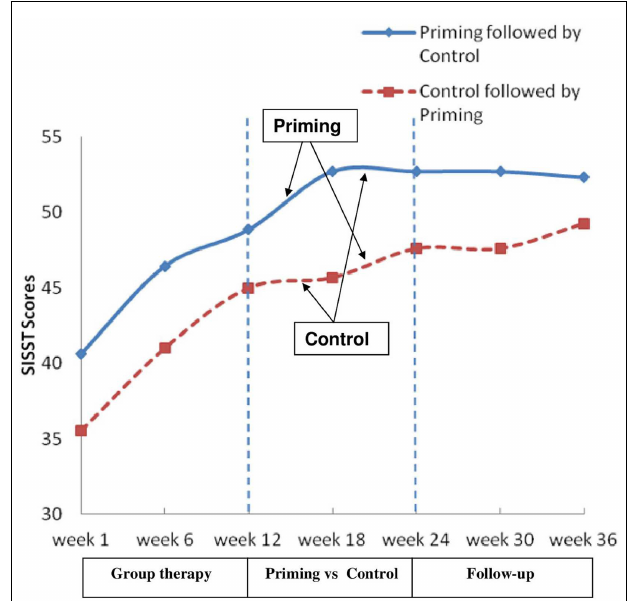
FIGURE 2 | Changes in SISST positive statements scores through the 36-weeks of the study.